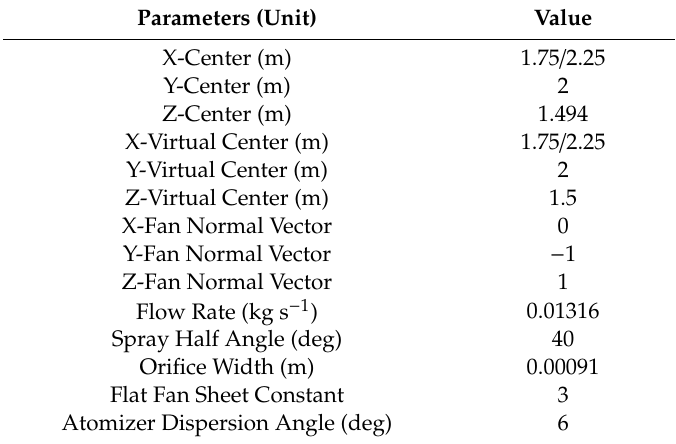
Table 1. Parameters of the flat fan atomizer used to simulate XR8002 nozzle.